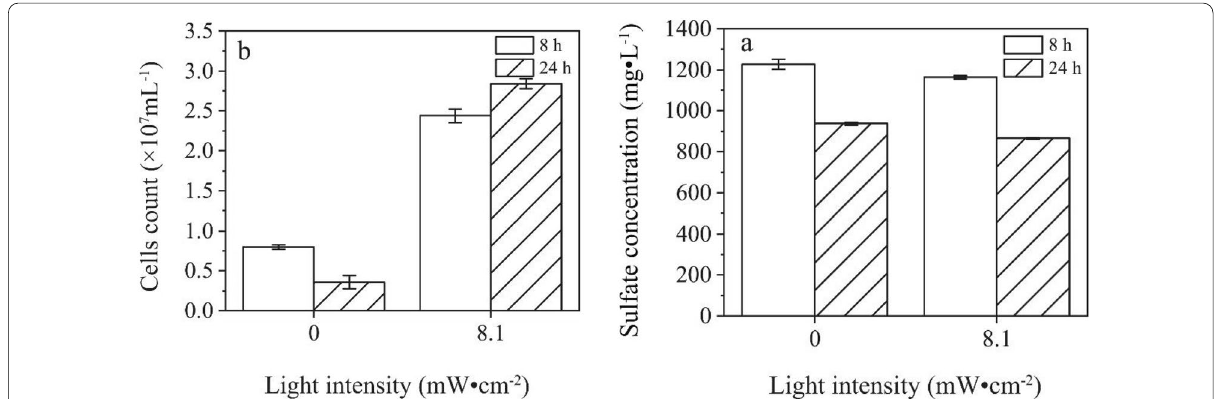
Fig. 9 Effect of CdS NPs on growth of C09 and reduction of sulfate under light. a Sulfate concentration at 8 h and 24 h; b Biomass at 8 h and 24